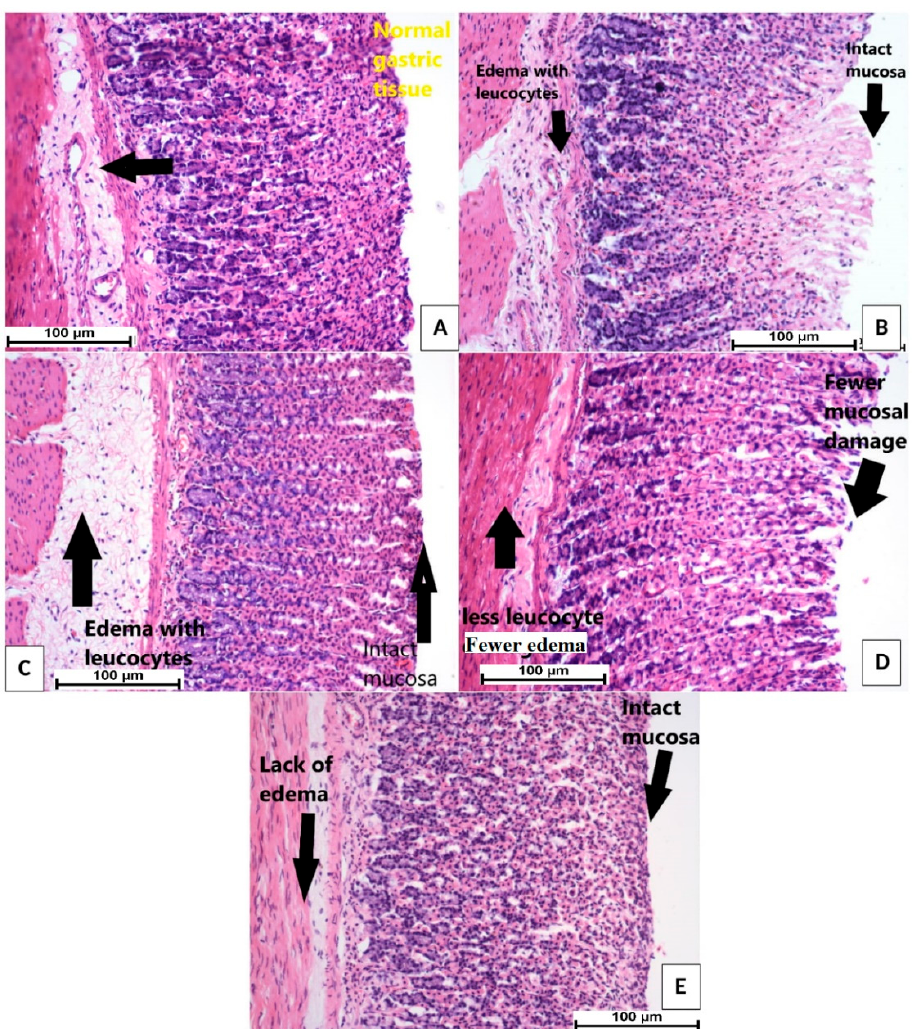
Figure 4. Influences of the PDE on the microscopic views of the stomach tissues obtained from ethanol ‐ induced ulcerogenic rats. ( A ), normal control exhibited normal mucosal structure based on the microscopic views; ( B ), ulcer control had severe stomach injuries in their mucosal linings with multiple lesions areas; ( C ), reference rats (omeprazole, 20 mg/kg) experienced mild mucosal injury with the presence of edema and leukocytes in the submucosal areas; ( D ), rats administered 200 mg/kg of the PDE had moderate mucosal injuries with multiple; ( E ), rats administered 400 mg/kg of the PDE had mild mucosal damage with a lack of edema based on the microscopic views (H & E stain, magnification 20×).